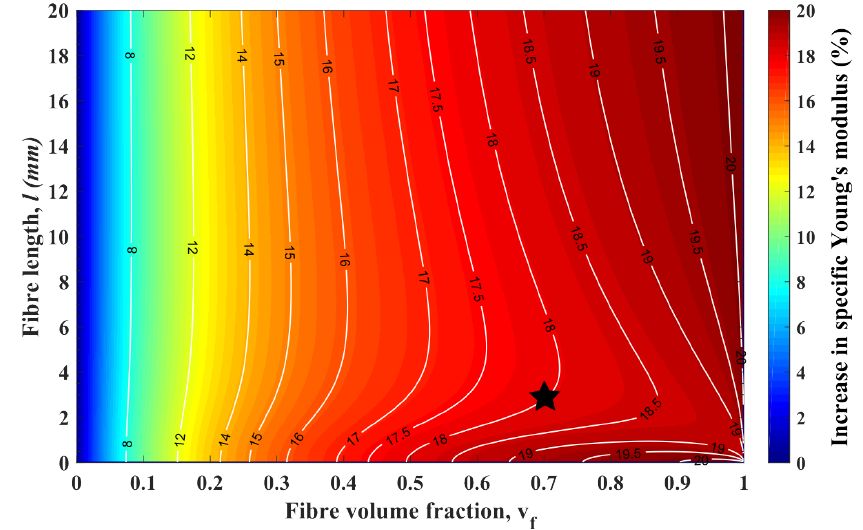
Figure 8. Contour plot of the increase in specific Young’s modulus, when highly aligned discontinuous glass fibre composites switched to highly aligned discontinuous flax fibre composites, in terms of fibre volume fraction and fibre length. White isolines are scaled by the right hand colour axis.